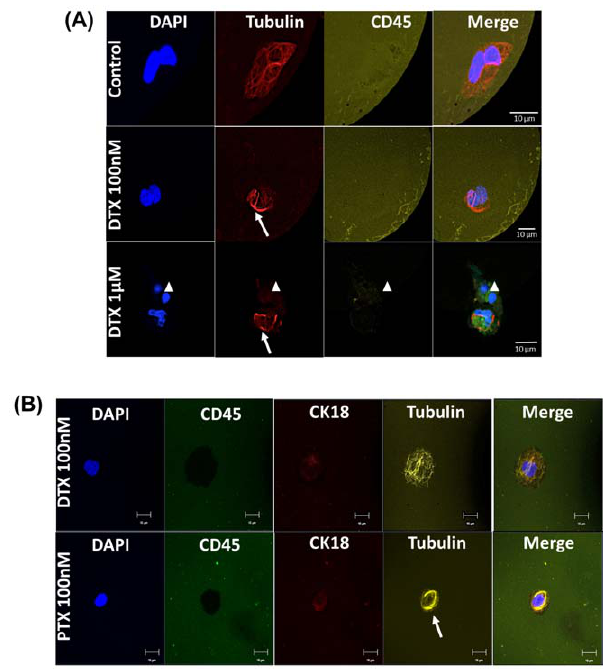
Figure 5. On-chip assessment of effective drug-target engage- ment on viable GEDI-captured CTCs. Tubulin response to taxane treatment can be assessed in GEDI-captured cells. (A) C4-2 prostate cancer cells were spiked at 200 cells/ml into healthy-donor whole blood. One ml of spiked blood was then flowed in each of three GEDI devices. Captured cells were incubated on each device at 37 u C for 24 hr with either DMSO control (upper panel) or DTX 100 nM (middle panel) or 1 m M (lower panel). Following drug treatment, cells were fixed and processed for immunofluorescence staining using antibodies against tubulin and CD45. DAPI was used as a DNA counterstain to evaluate nuclear integrity. Note the fine and intricate microtubule network in the DMSO control (top panel) and the distinct microtubule bundles in the DTX treated devices (arrows, middle and bottom panels). Apoptotic nuclei were observed at higher DTX concentrations (arrowhead, bottom panel). (B) GEDI-captured CTCs from the blood of a CRPC patient were treated ex vivo on the GEDI device with 100 nM DTX (top panel) or the addition of 100 nM PTX (bottom panel) at 37 u C for 24 hr. Following drug treatment the PSMA-captured cells were fixed and processed for immunofluorescence staining as in (A) with the addition of cytokeratin- 18 as an alternative epithelial marker. In this patient, the presence of an unperturbed microtubule network following DTX treatment (top panel) indicates lack of efficient drug-target engagement. In contrast, addition of PTX resulted in microtubule bundling (bottom panel).